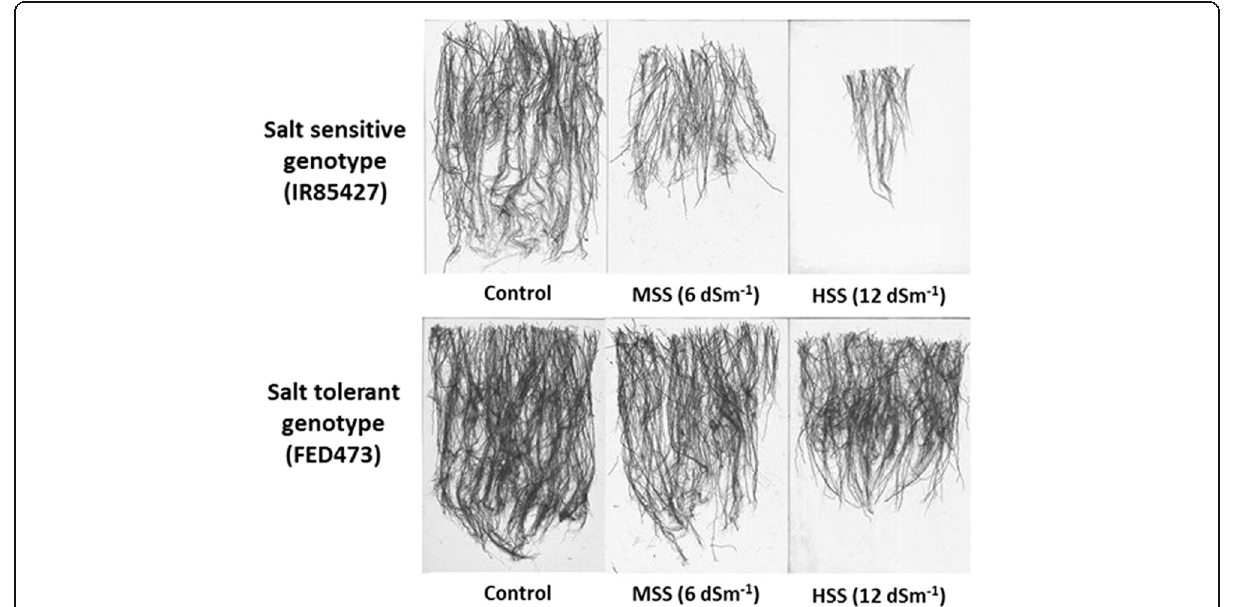
Fig. 4 Representative scanned root images of salt-sensitive ( a ) and salt tolerant ( b ) rice genotypes, at three different salinity levels [control, moderate salt stress (MSS), and high salt stress (HSS), respectively